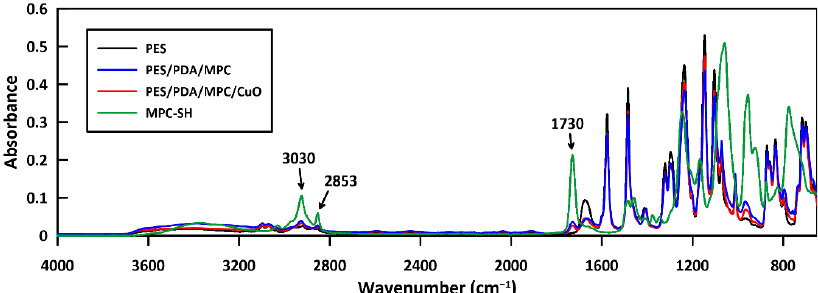
Figure 8. FTIR spectra of PES, PES/PDA/MPC, and PES/PDA/MPC/CuO membranes and pure MPC-SH. The peak visible at 1730 cm − 1 is from the carbonyl group in MPC-SH. Peaks at 3030 cm − 1 and 2853 cm − 1 are C-H stretching peaks. These peaks occur in spectra of MPC-SH, PES/PDA/MPC, and PES/PDA/MPC/CuO, but not PES.